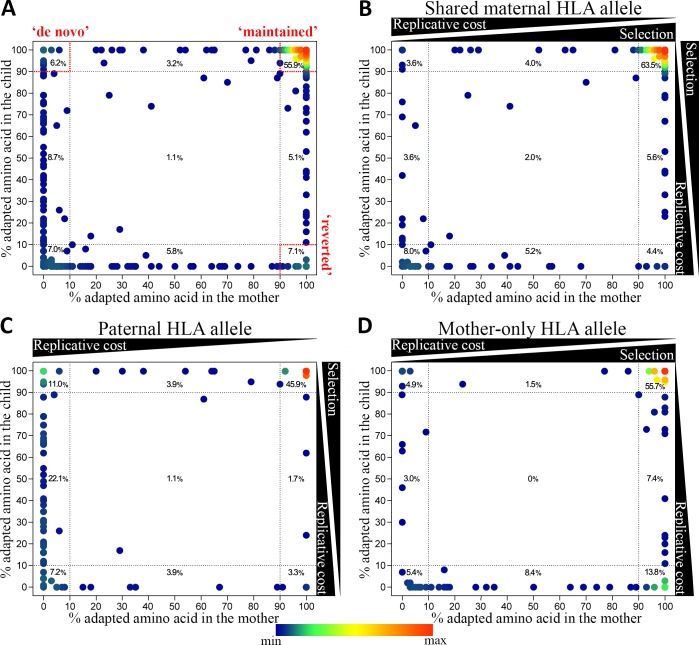
Adaptation dynamics following transmission affected by bottleneck event, immune selection pressure, replicative cost and drift.(A) The % of quasispecies for all adapted amino acids in Gag, Pol, and Nef in the mother/child pairs (N = 633) were plotted on the x-axis for the mother, and the y-axis for the child. Points are superimposed on each other and the color range reflects number of superimposed points with red (maximum, max) and blue (minimum, min). ‘Maintained’ adaptations are present in the top right corner (≥90% in the child), ‘reverted’ in the bottom right corner (<10% in the child), and ‘de novo’ adaptations along the y-axis (<10% in the mother), with respect to the child. (B) Adaptations that are potentially under immune selection pressure in both the mother and child (shared maternal HLA; N = 249; scenarios 1–3 in the child from Fig 1). (C) Adaptations that are in a non-selective immune environment in the mother, but potential selective environment in the child (paternal HLA; N = 181; scenarios 4–5 for the mother and 1–3 for the child from Fig 1). (D) Adaptations that are potentially under a selective environment in the mother, but a non-selective immune environment in the child (mother-only HLA; N = 203; scenarios 1–3 for the mother and 4–5 for the child from Fig 1). In all panels, percentages denote adaptations that are present in that quadrant for that grouping. Panels B-D also indicate the likely influence of selection on, and replicative cost of (theoretical), adaptations along the axes.